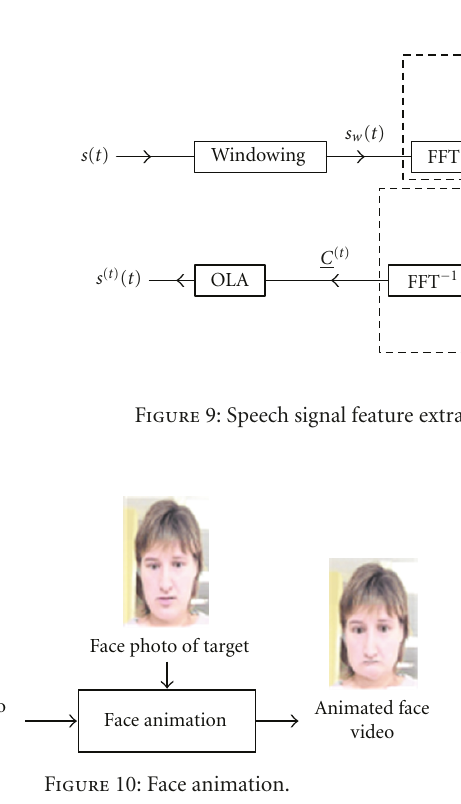
Figure 8: Signal-level transformation parameters tuned with a gradient descent algorithm.